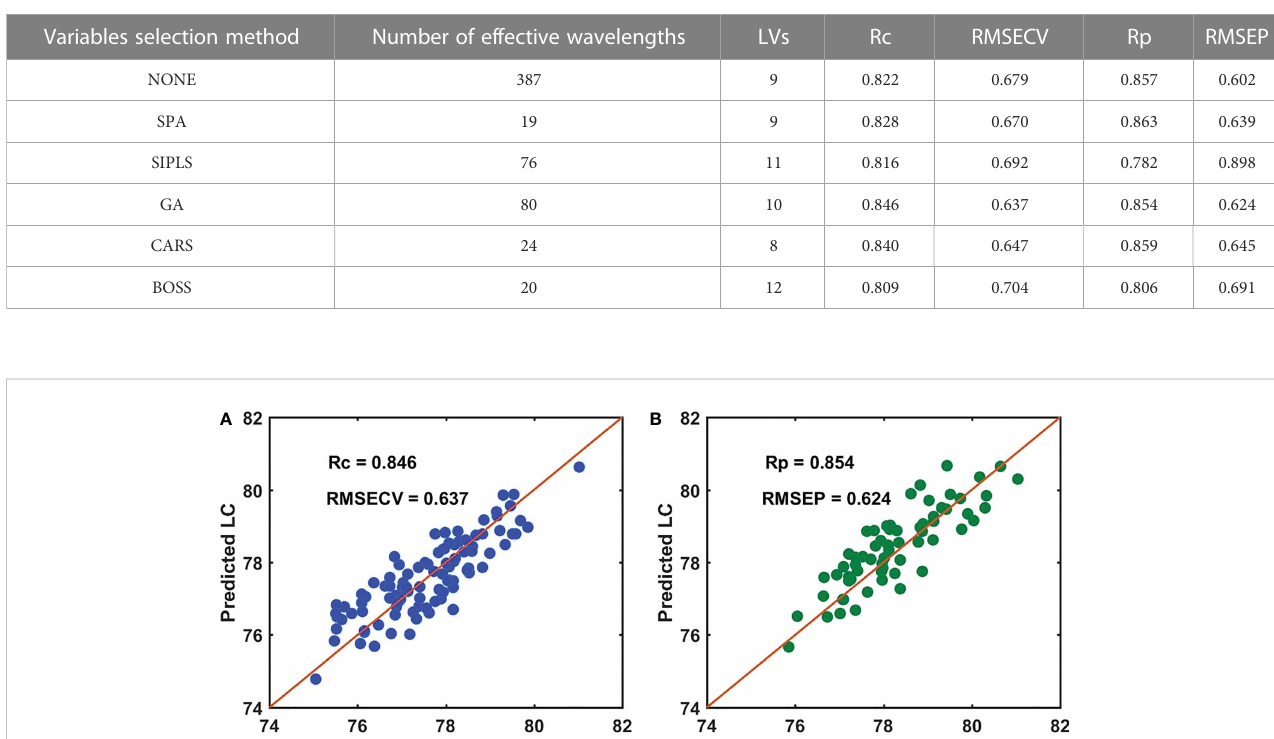
TABLE 3 Performance of the model based on different variables selection methods to measure the LC of batch A samples.